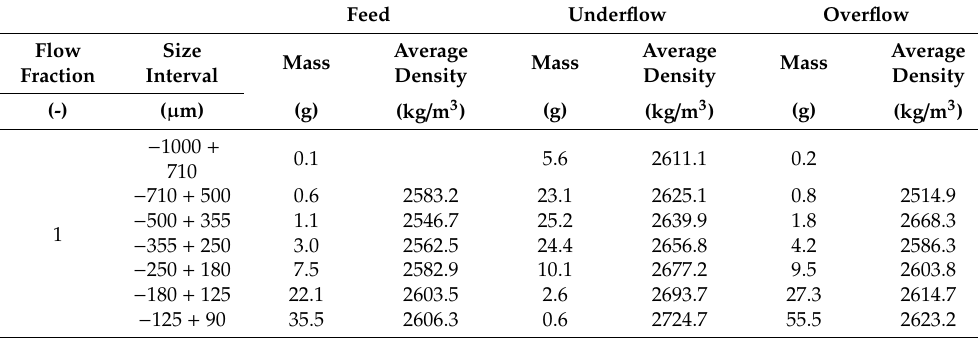
Table A2. Raw sample mass and pycnometry data for the gold-bearing ore feed, underflow and overflow sized LST flow fractionation